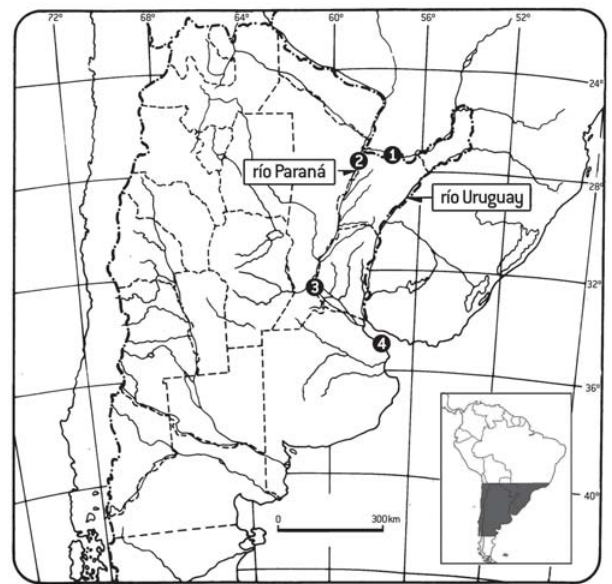
Fig. 7. Distribution of examined material of Astyanax erythropterus . 1 ) Yahape and Ituzaingó cities. 2 ) Chaco. 3 ) Parque Nacional Pre-Delta. 4 ) Río de la Plata